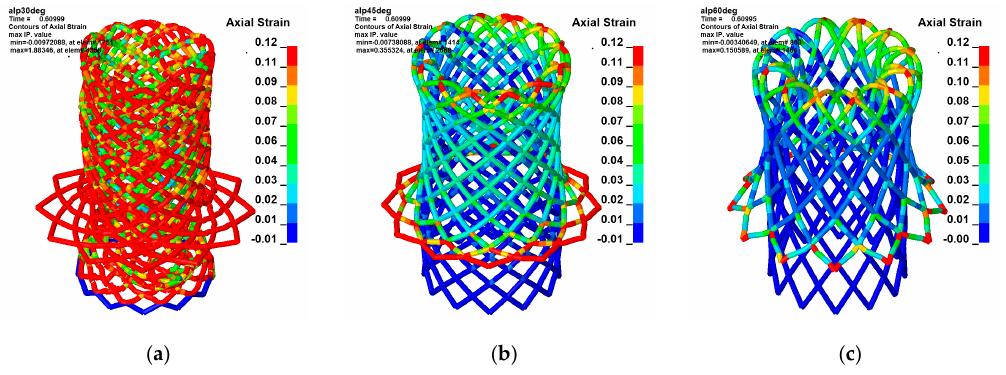
Figure 11. Axial strain for net angle of 30° ( a ), 45° ( b ) and 60° ( c ). The positive legend maximum is fixed at a strain of 0.12.